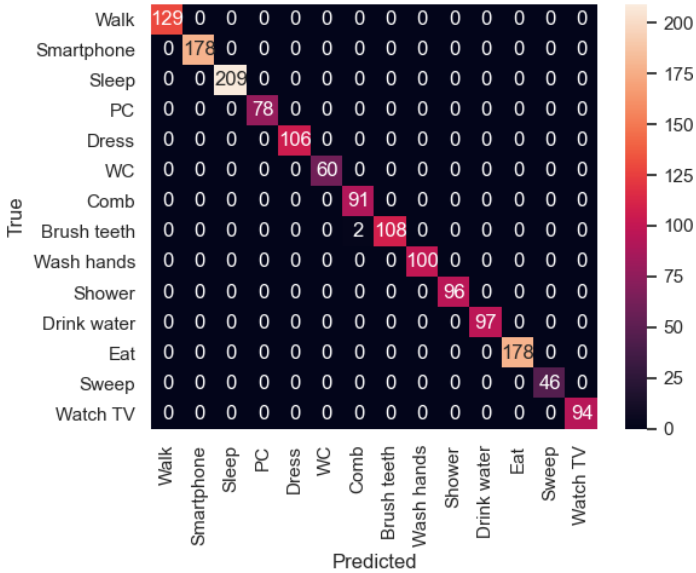
Figure 22. Confusion matrix of the experiment